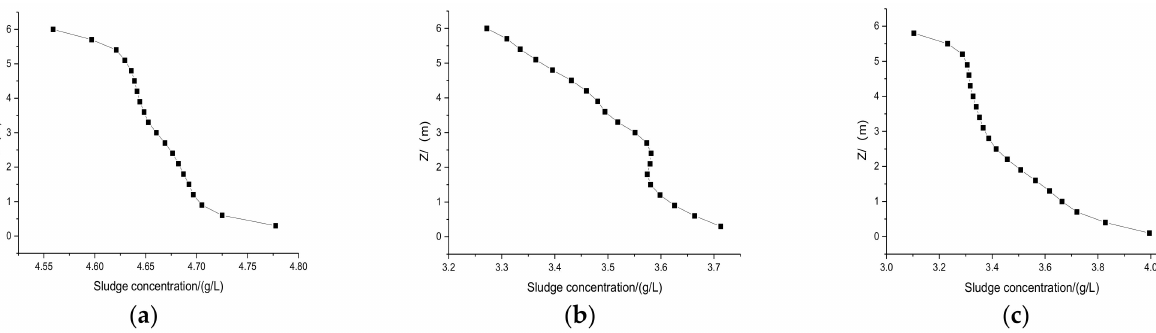
Figure 8. Curves of average sludge concentration at each section. ( a ) Biological selection pool; ( b ) Anaerobic pool; ( c ) Anoxic pool.